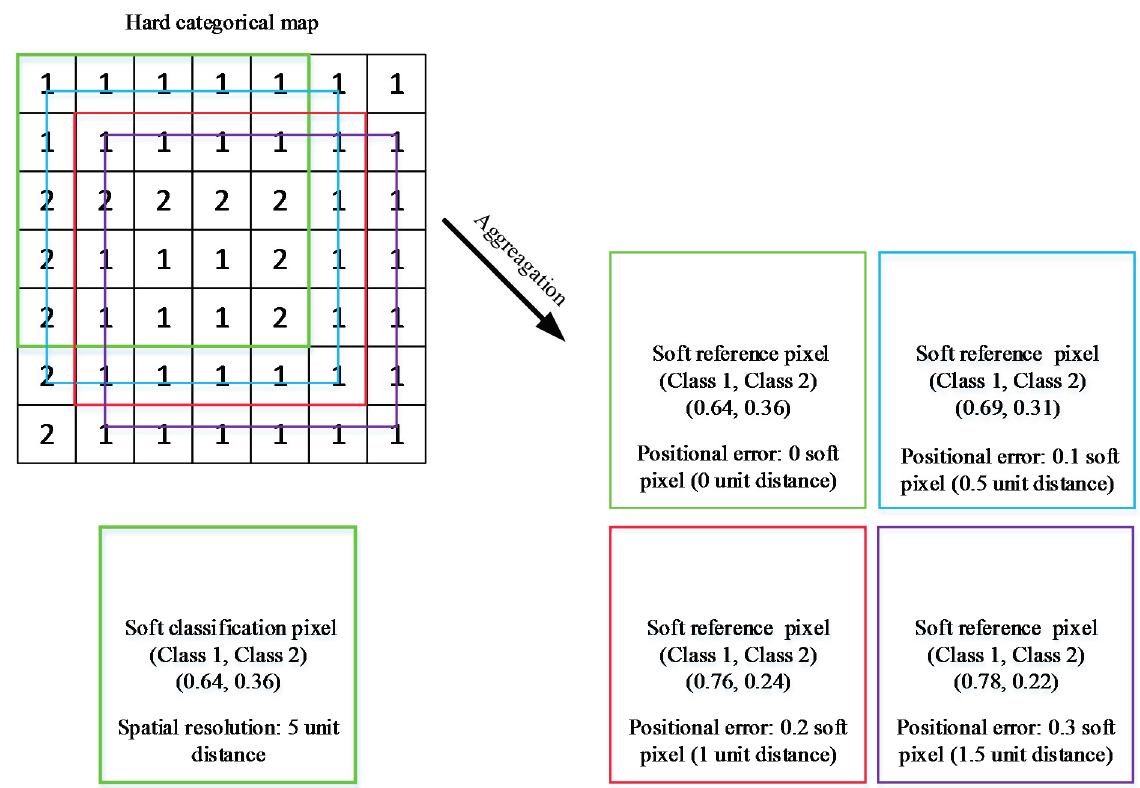
Figure 2. Example of a simulated soft classification and reference pixel (spatial resolution: 5 unit distance) at levels of 0.0, 0.1, 0.2 and 0.3 soft pixel’s positional error respectively